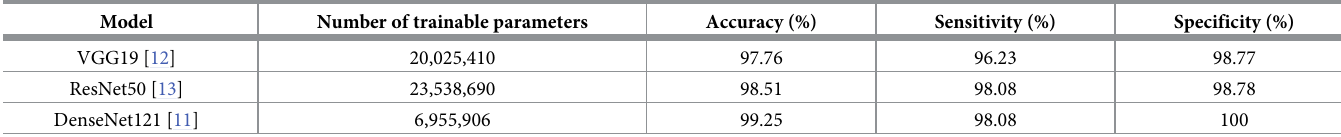
Table 3. Performance comparison of various